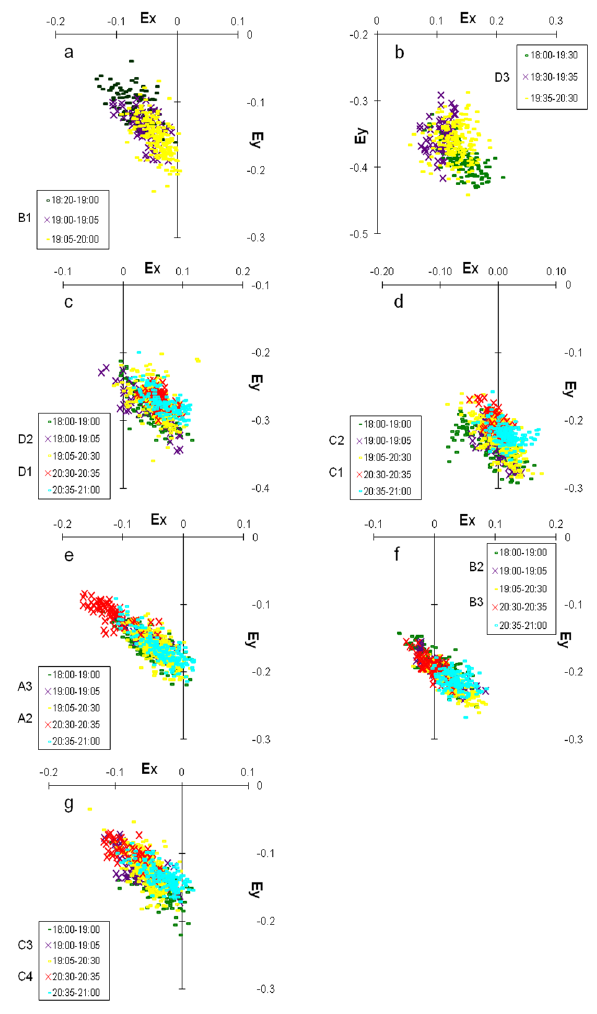
Figure 9. Electric polarization vectors related to the field compo- nents, E and E (in mV/m), observed before and after the shots in x y Figure 1.